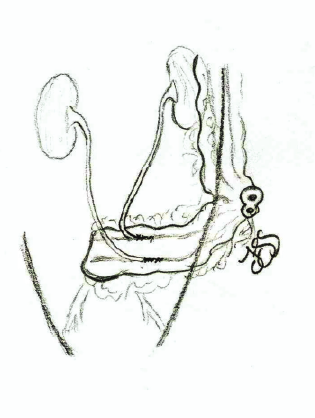
Figure 1: Schematic representation of double barreled wet colo-